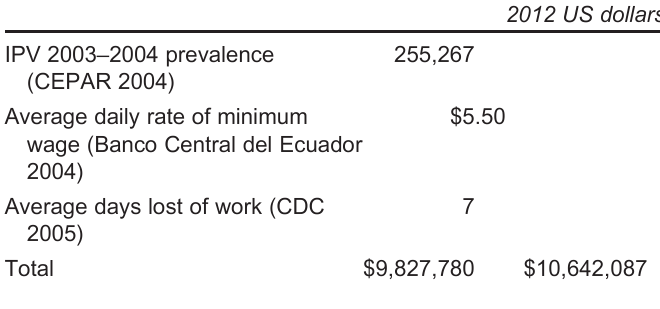
Table 4. Indirect costs from losses in productivity.